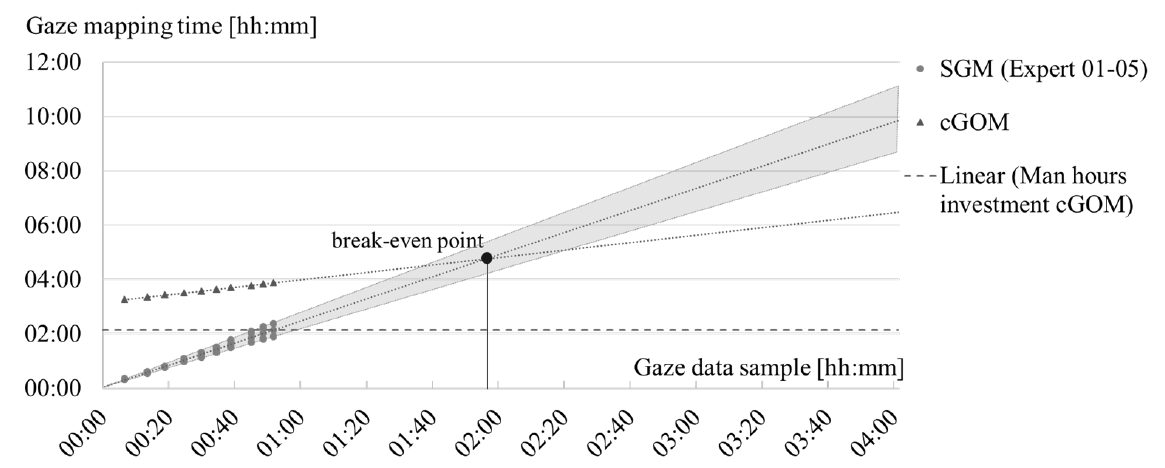
Figure 5: Graphical representation of data samples size in hours and minutes (abscissa) and time for mapping in hours (ordinate) for manual mapping using SGM (●) and computational mapping using cGOM (▲). The linear approximation is based on the measured sub-times data. According to the approximation, a sample size of 4 hours video time would require 6.5 hours for the computational mapping and 10 hours for the manual mapping on average. The grey cone represents the distribution of the manual mapping and the linear continuation. The break-even point is at approx. 02:00h gaze data sample size. The break-even point for the man hours invest- ment for cGOM is at approx. 01:00h gaze data sample